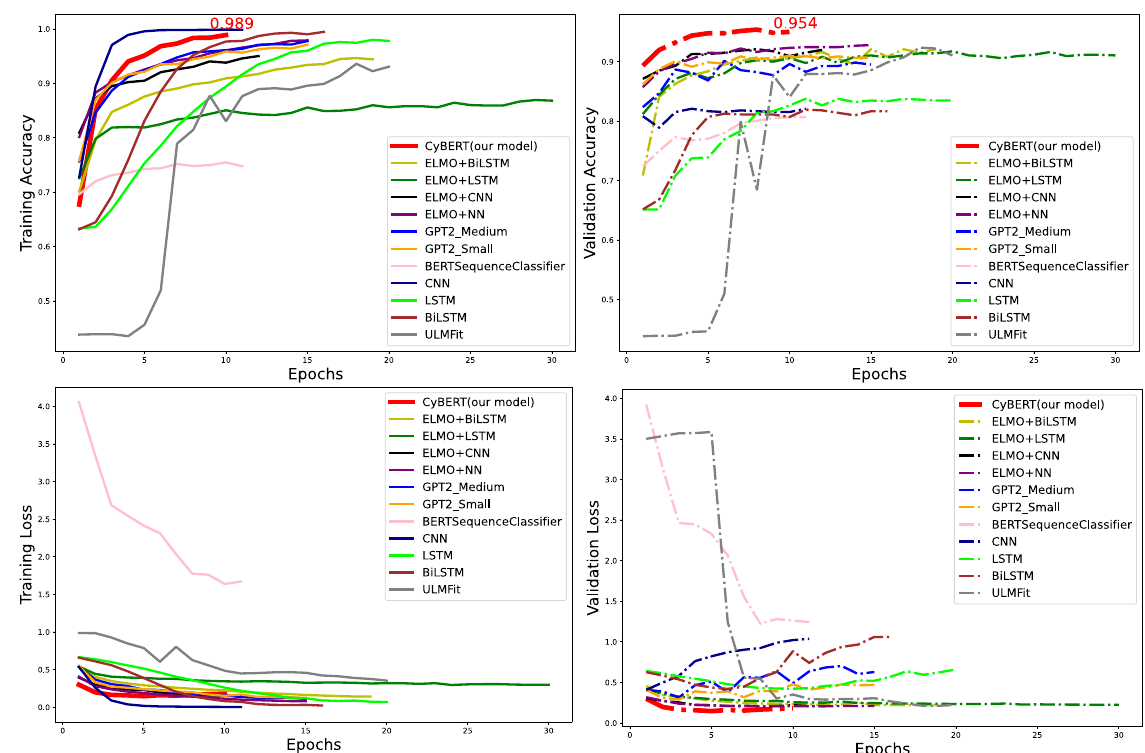
Figure 10. Comparing training accuracy ( left top ), validation accuracy ( right top ), training Loss ( bottom left ), and validation loss ( bottom right ) for all